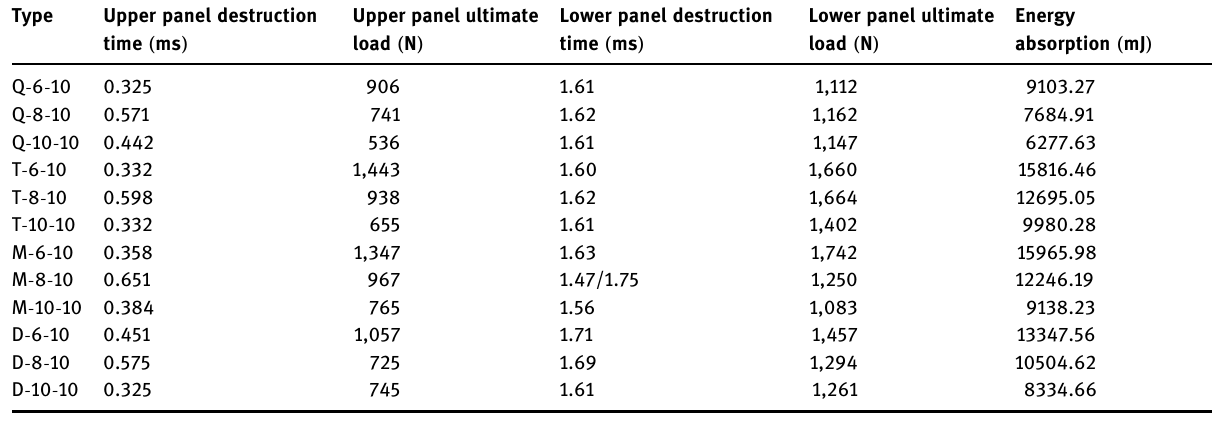
Table 2: In fl uence of single grid width on ultimate load and energy parameters Type